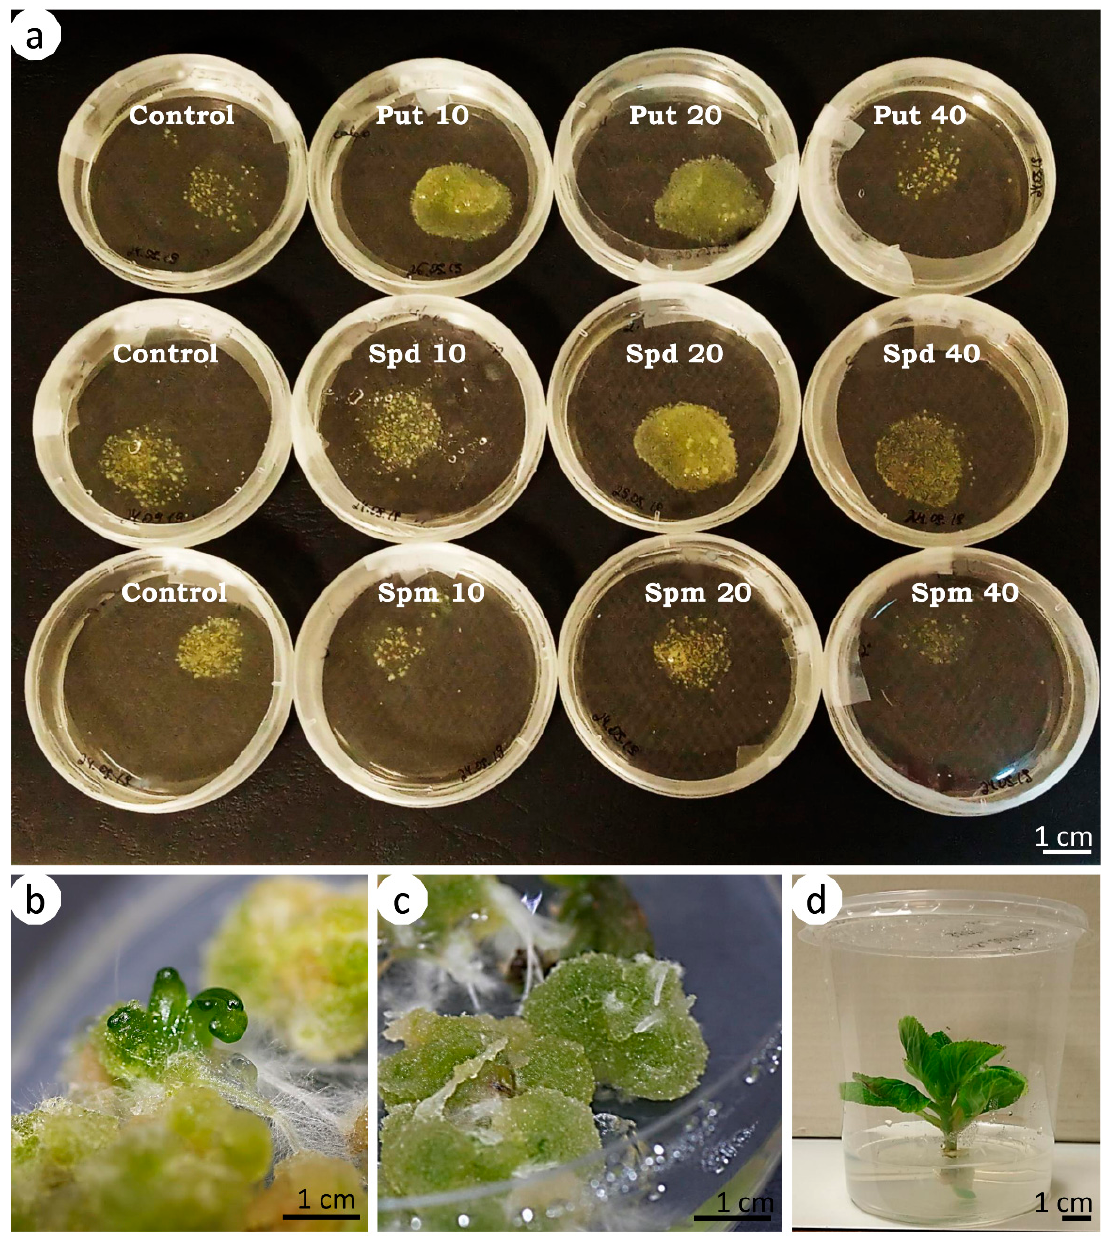
Figure 6. Callus development and organogenesis from the protoplast-derived cells of Brassica oleracea L. var. capitata treated with putrescine (Put), spermidine (Spd), and spermine (Spm) and the control. The alginate layers were overgrown with calli tissue of different intensities, depending on the type of polyamine and its concentrations (in µ M) and the control ( a ); shoot ( b ) and root ( c ) organogenesis from protoplast-derived cells; regenerated shoot ( d ). Scale bar: 1